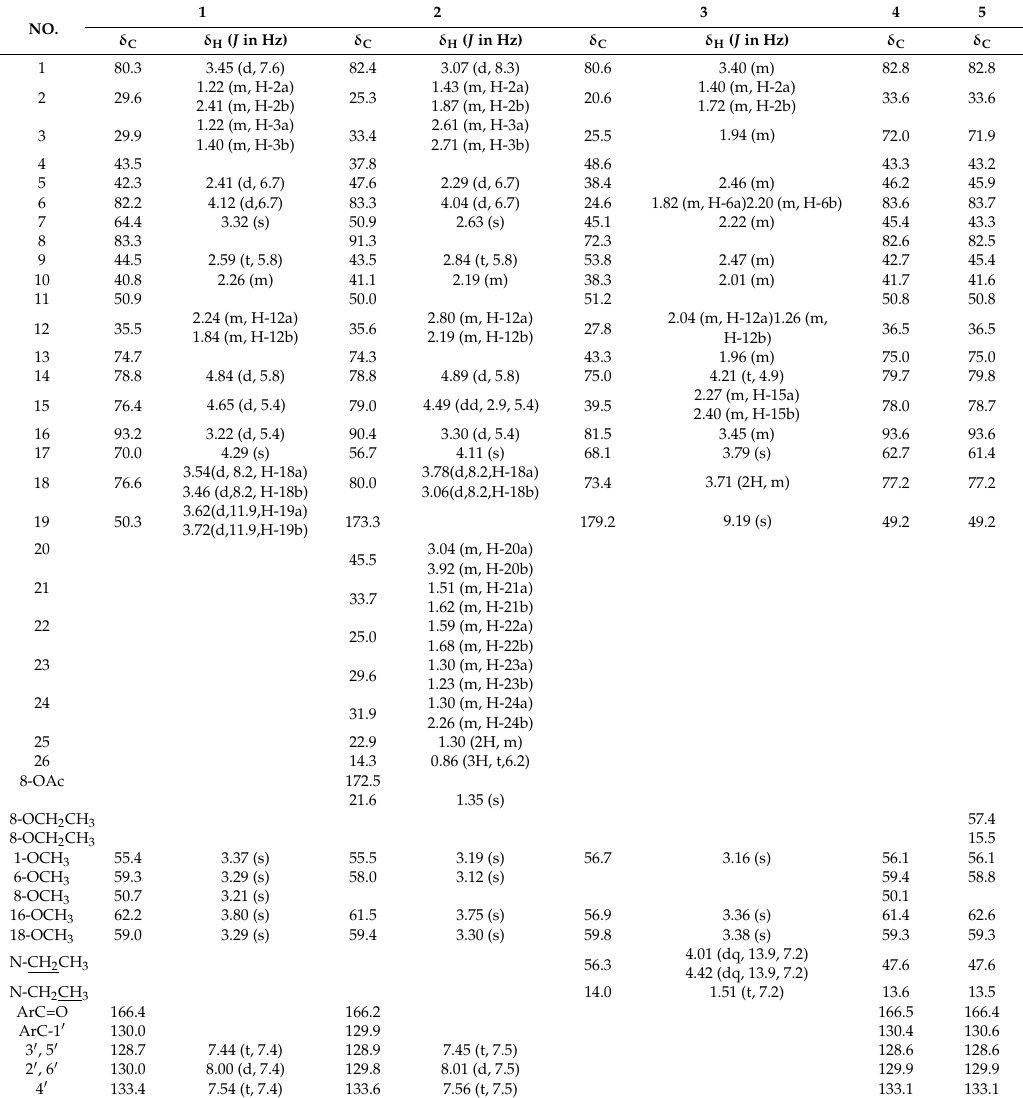
Table 1. 1 H-NMR and 13 C-NMR spectral data for Compounds 1 – 5